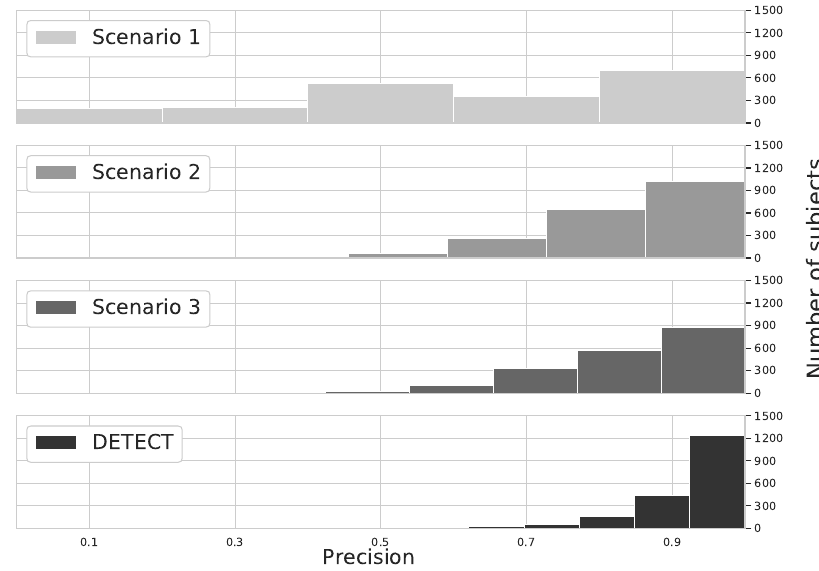
Figure 7. Precision distribution for the different user identification